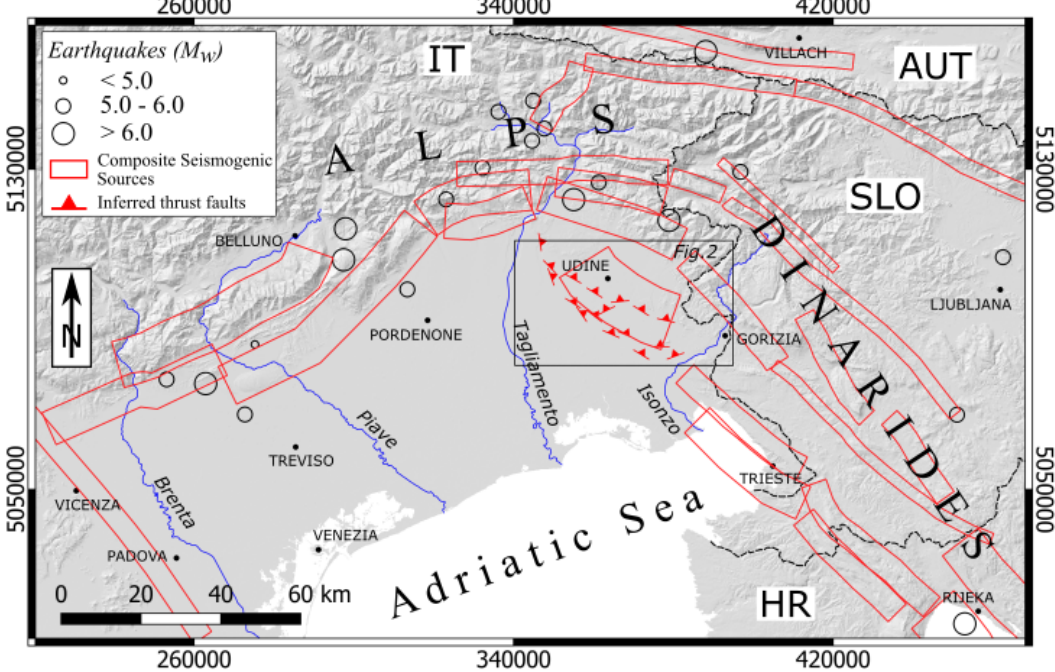
Figure 1. Seismotectonic setting of the northeastern corner of Adria. IT = Italy, AUT = Austria, SLO = Slovenia, HR = Croatia. Red polygons represent the fault plane projections of the Composite Seismogenic Sources, the unsegmented fault systems of the region capable of M ≥ 6 earthquakes. The black circles represent the largest historical earthquakes that occurred in this region, data taken from EMEC 2012 [6]. The black rectangle indicates the area shown in Figure 2, which encompasses the Udine-Buttrio Thrust (UB), main subject of this study and not included in the DISS. The hillshaded DEM was taken from the SRTM1 data from NASA. Coordinates here and in all following figures are in WGS 84/UTM zone